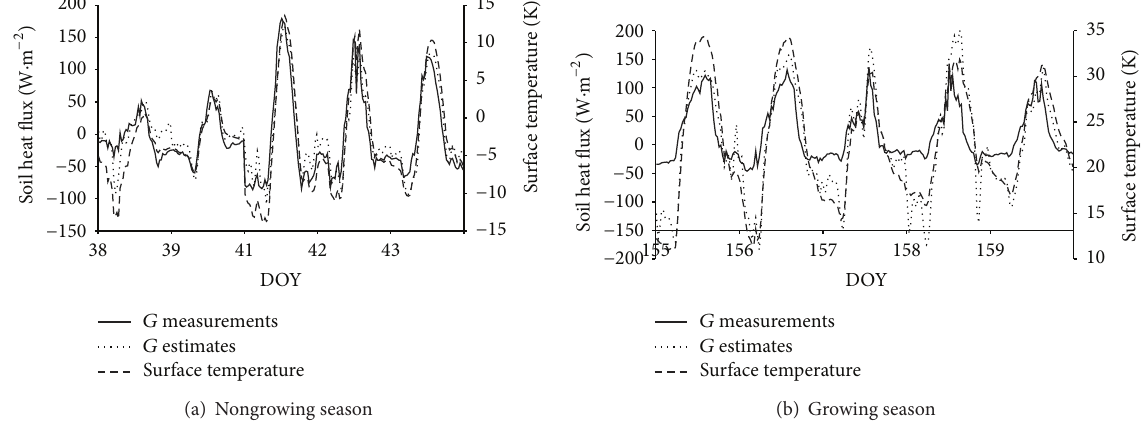
Figure 6: The diurnal course of 𝐺 estimates, 𝐺 measurements, and surface temperatures of 5